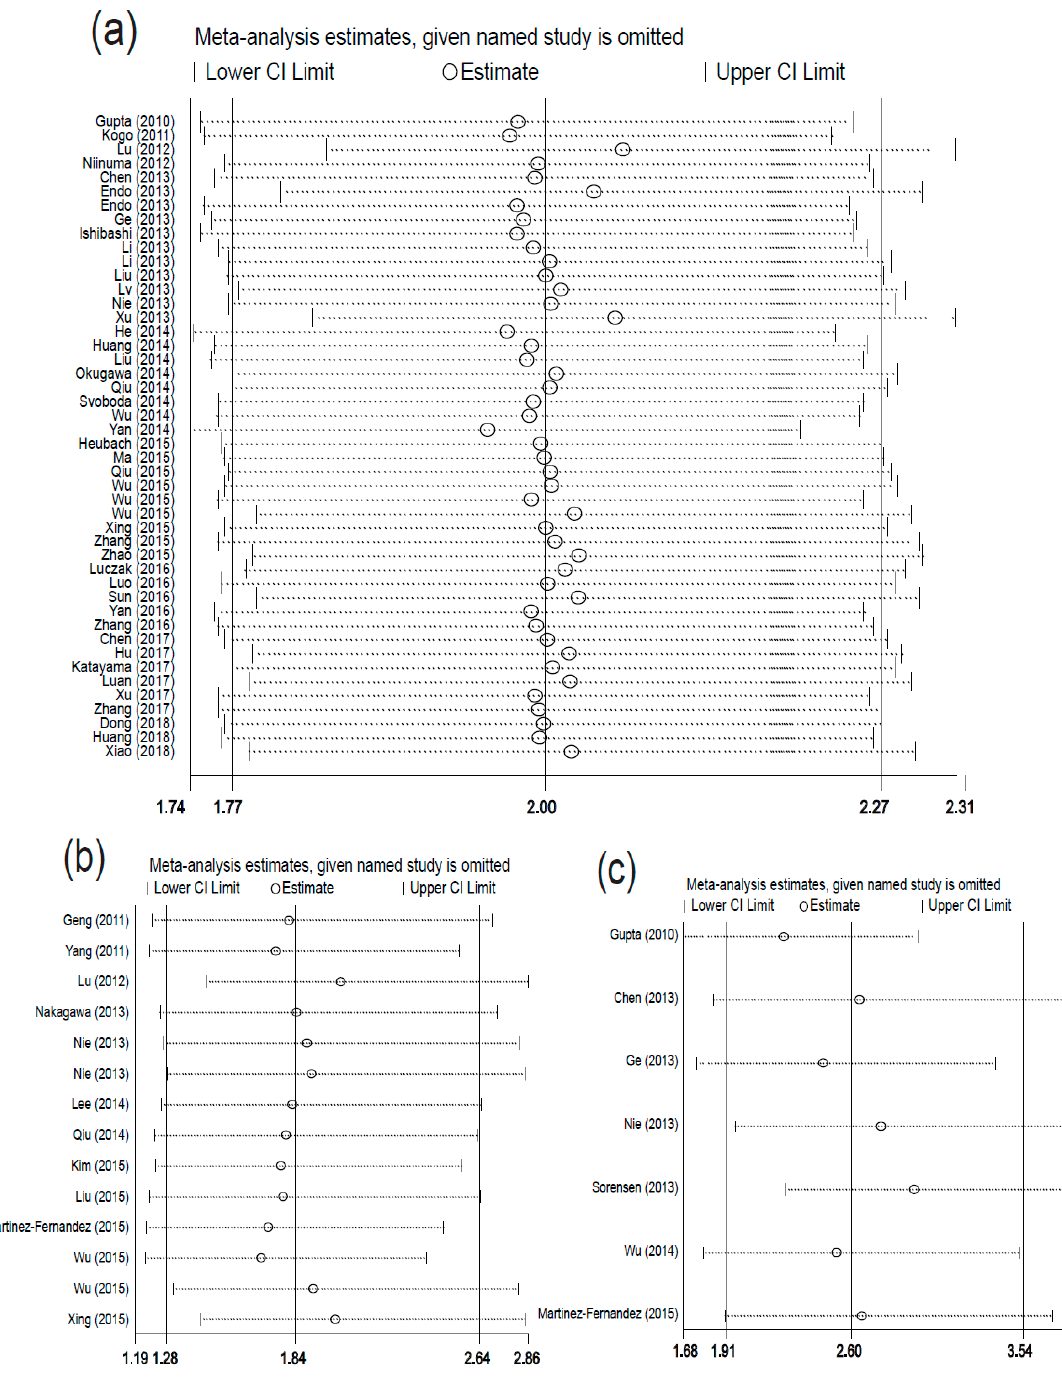
Figure 5. Sensitivity analysis of each eligible study. ( a ) OS individual studies, ( b ) RFS/DFS individual studies and ( c ) MFS/PFS individual studies.